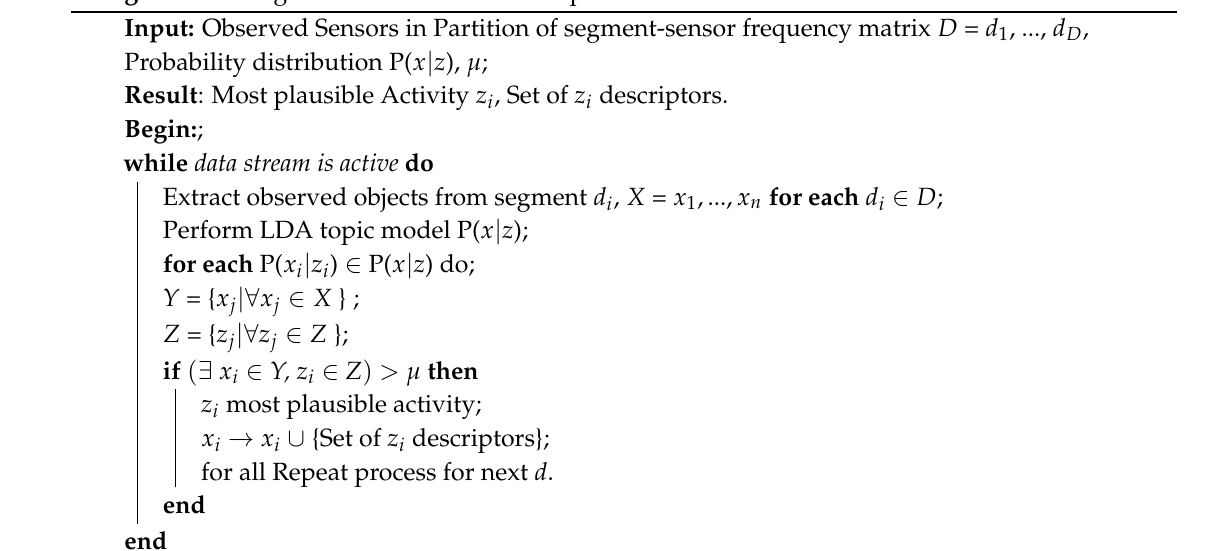
Algorithm 1: Algorithm for Context Descriptors of